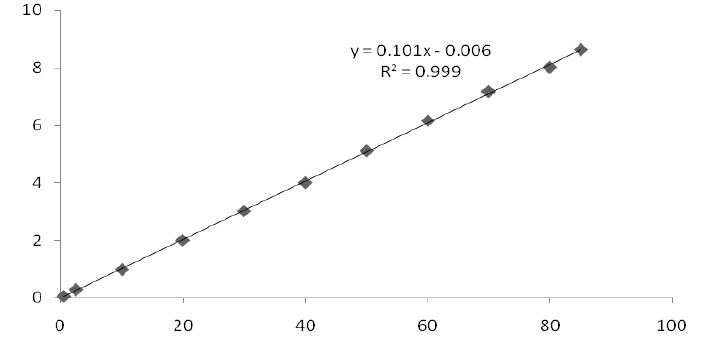
Figure 3: Calibration curve of Etoricoxib.